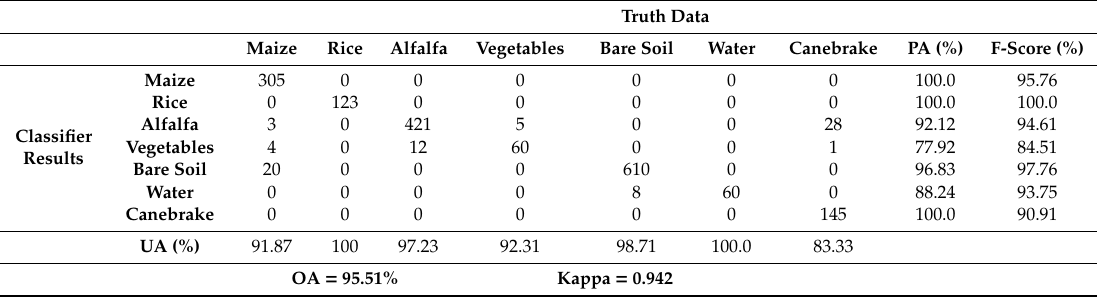
Table 7. Confusion matrix of the classification-feature selection ensemble procedure. The values which have been displayed for each class are the pixels number of validation